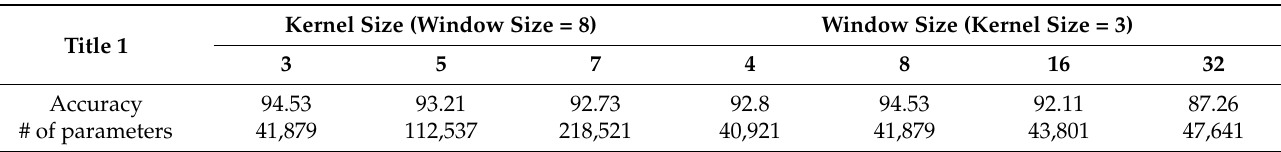
Table 3. Optimal values of kernel and window